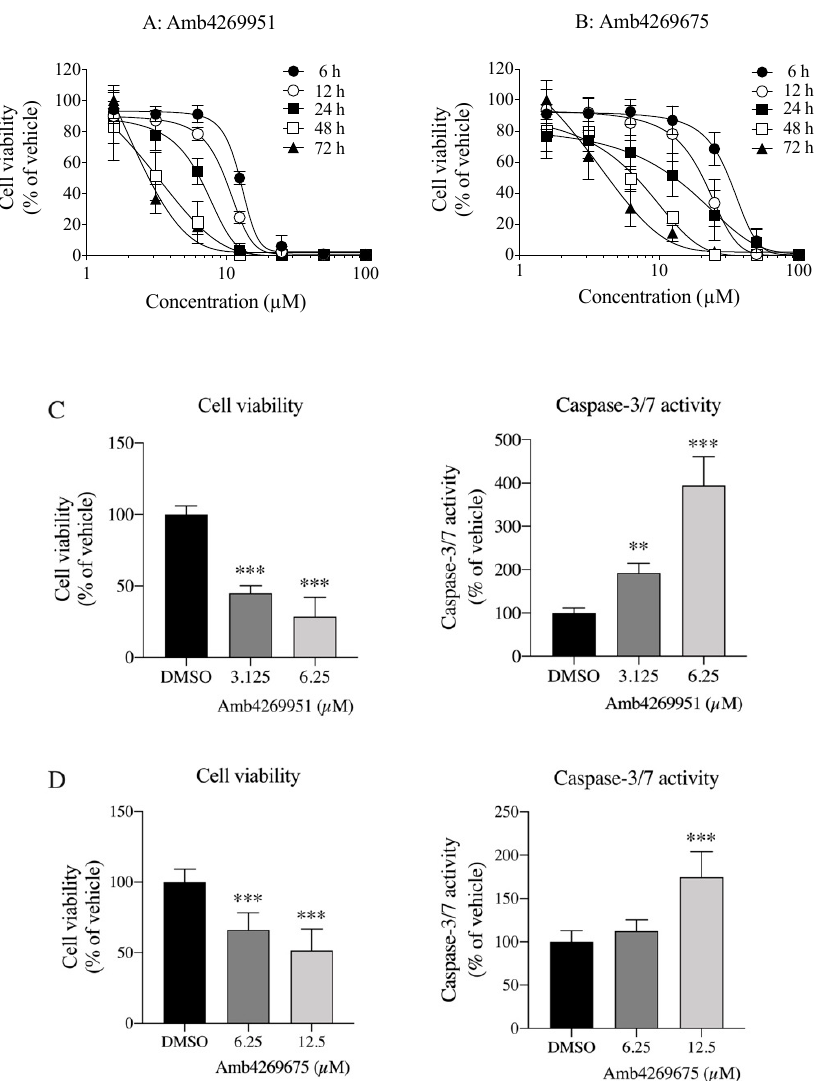
Figure 7. E ff ects of Amb4269951 and Amb4269675 on cell viability in MIA PaCa-2 cells. Cells incubated with 1.6 to 100 µ M ( A ) Amb4269951 and ( B ) Amb4269675 for 6, 12, 24, 48, and 72 h; then, cell numbers were measured ( n = 3). Results calculated as 100% of findings in vehicle control. E ff ects of ( C ) Amb4269951 and ( D ) Amb4269675 on cell viability and caspase-3 / 7 activity in MIA PaCa-2 cells ( n = 4). Cells incubated with 3.125 and 6.25 µ M Amb4269951, and 6.25 and 12.5 µ M Amb4269675 for 24 h; then, cell number and caspase-3 / 7 activity were measured. Results calculated as 100% of findings in vehicle control. ** p < 0.01 and *** p < 0.001 for one-way ANOVA with Dunnett’s multiple-comparisons test compared to vehicle control (DMSO).